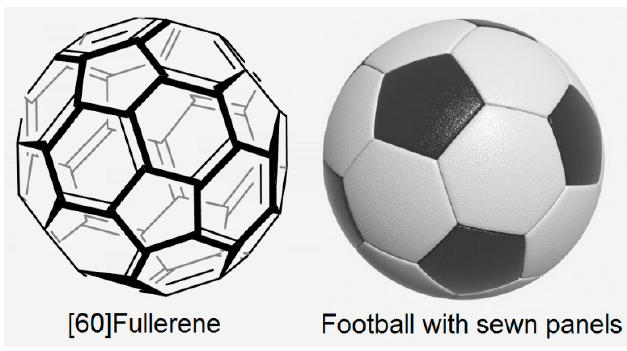
Figure 61. Three-dimensional (3D) representation of [60]Fullerene and a football with sewn panels.